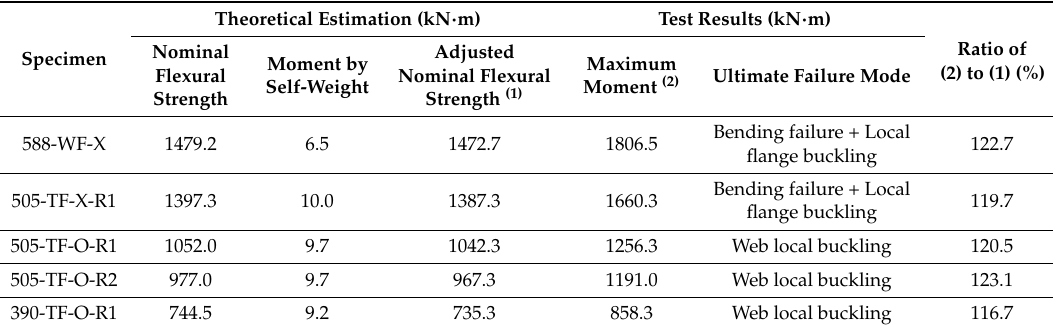
Table 10. Test results of the non-composite